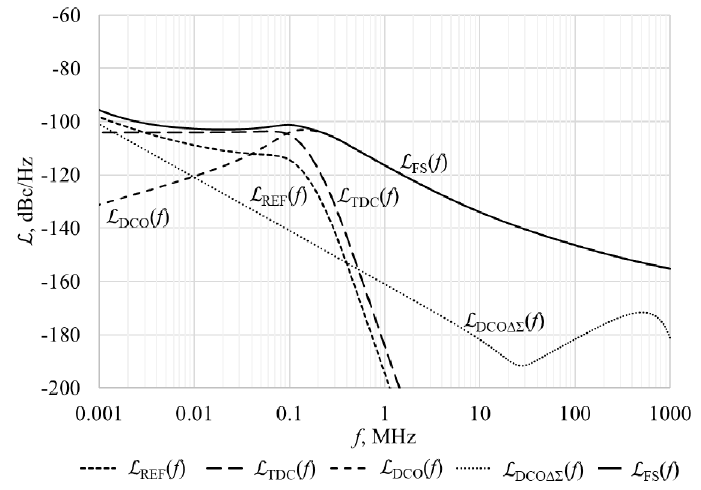
Figure 11. Calculated achievable phase noise and its components of frequency synthesiser, when presented time to digital converter, digitally controlled oscillator and synthesiser’s filter are used.